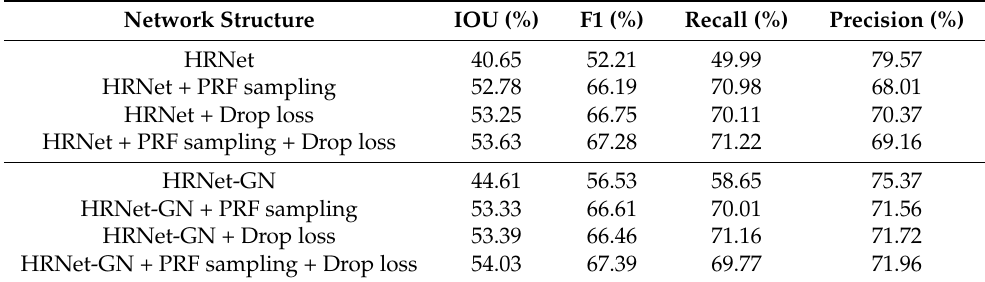
Table 4. Ablation experiment results obtained based on HRNet and